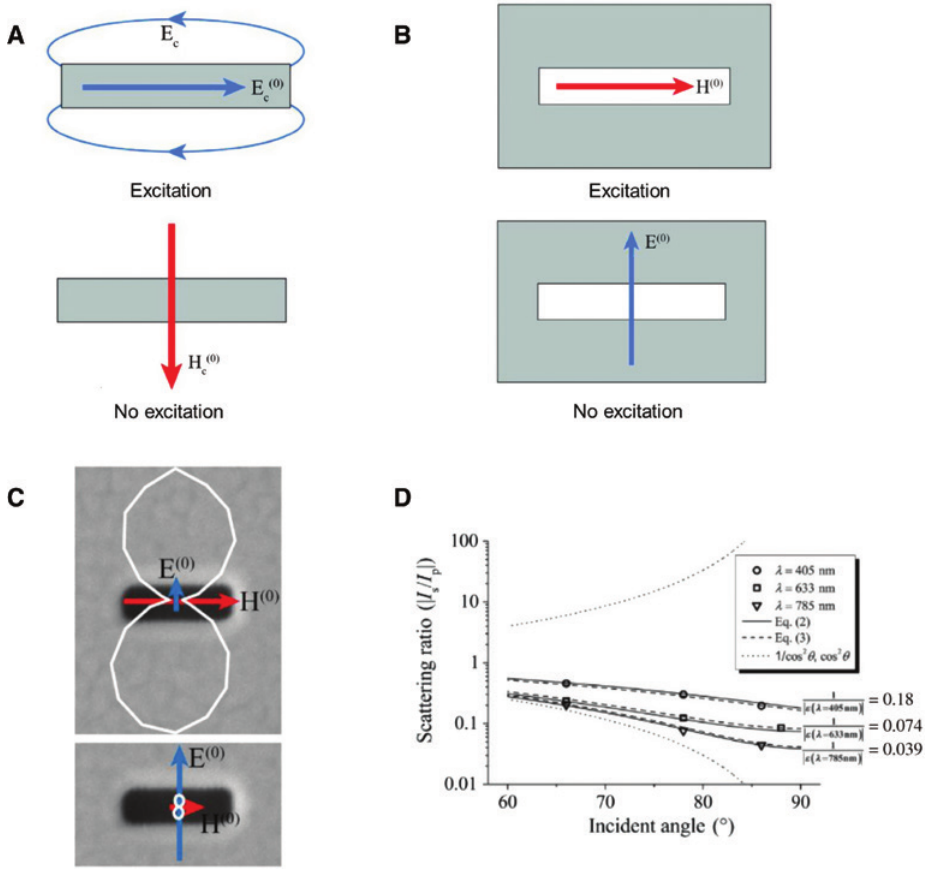
Figure 8: Dominant incident fields in optical slot antennas. (A) Schematics of rod antenna excitation by incident E-fields parallel in antenna length. (B) Schematics of slot antenna excitation by incident H-fields parallel in antenna length. Because a slot antenna is the Babinet complementary structure of a rod antenna, the roles of the H-fields and E-fields are reversed. (C) Polar plot of scattered intensity when the p-polarization (top) and s-polarization (bottom) are incident. The blue and red arrows represent the incident tangential E-fields and H-fields. (D) Ratio of scattering intensities between the s-polarization and the p-polarization as functions of the incident angle. The circles, rectangles, and triangles are experimental data. The measured ratios of | I / I | can be fitted by 1/ | ε ( λ ) |. Reprinted with permission from Ref. [38]. Copyright 2016 Springer s p